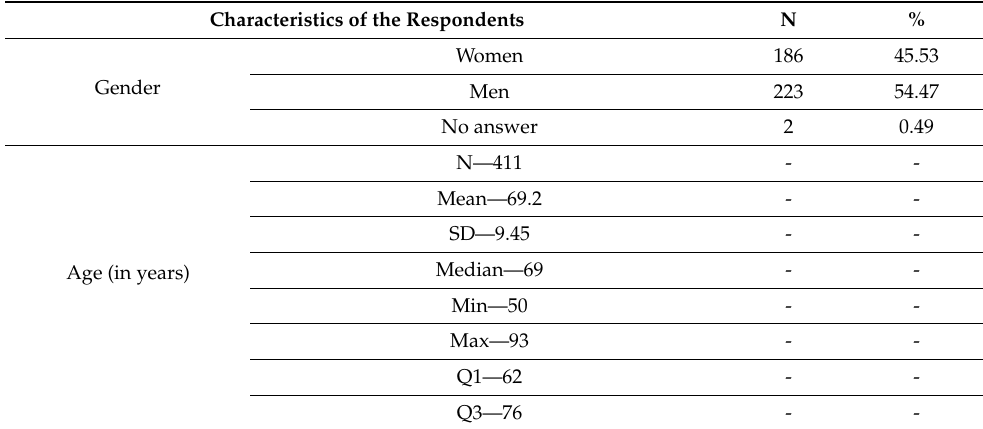
Table 1. Characteristics of the